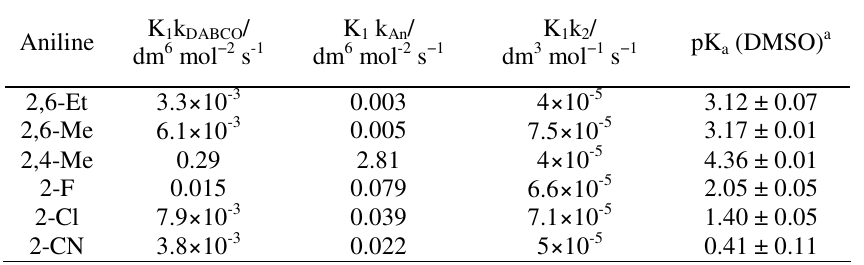
Table 2. Summary of results for the reactions of anilines, 2a–f, with 2-phenoxy-3,5- dinitropyridine, 1 , in DMSO at 25 o